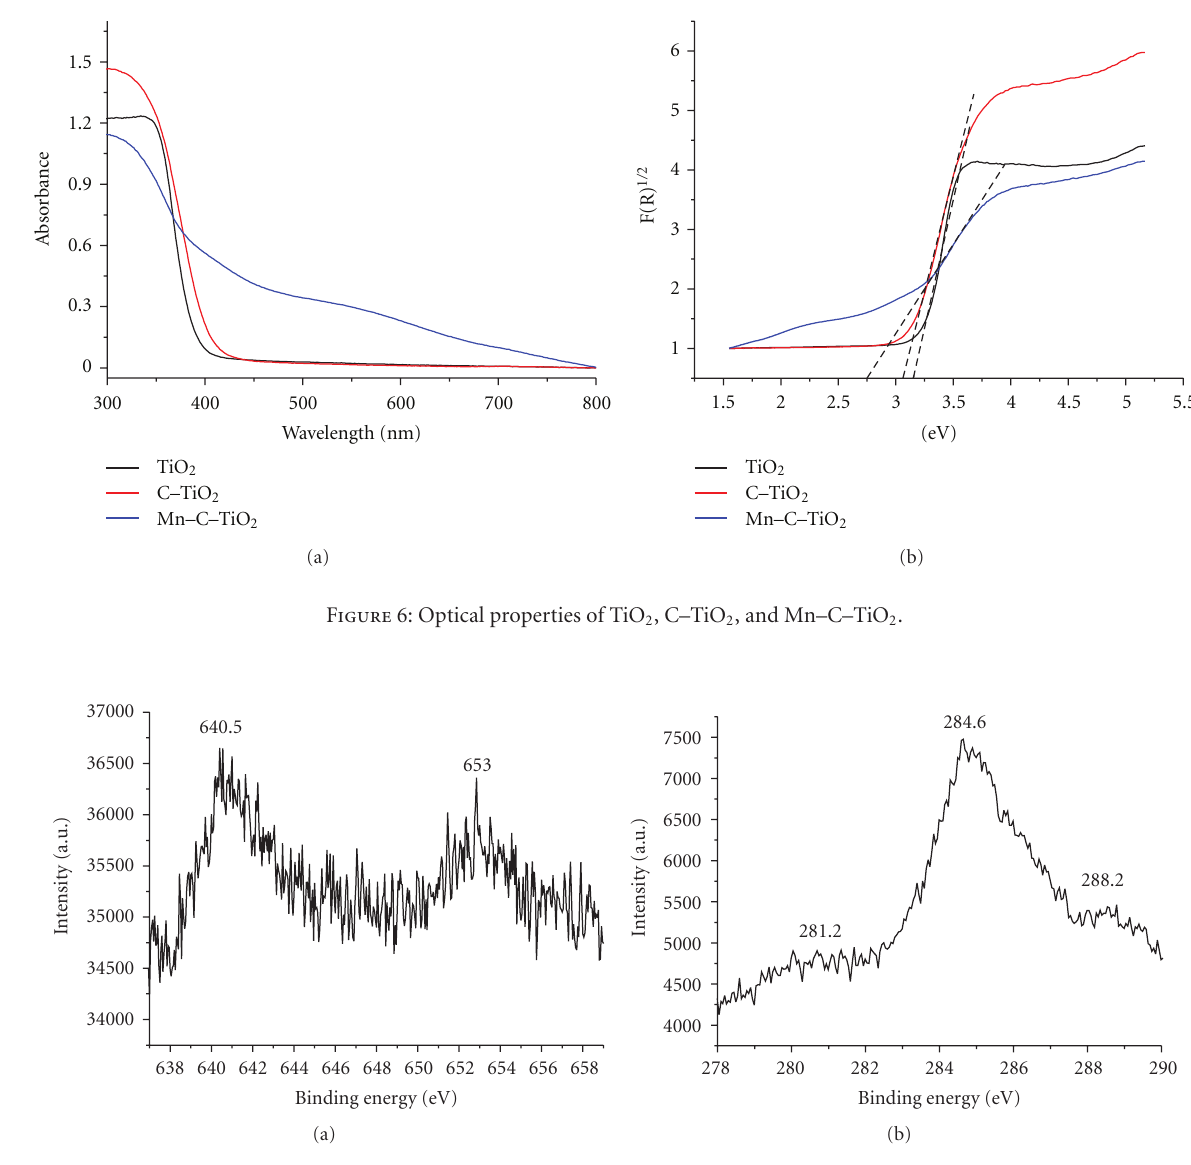
Figure 7: XPS spectra of codoped TiO 2 nanotube arrays. (a) A spectrum of Mn 2p; (b) a spectrum of C